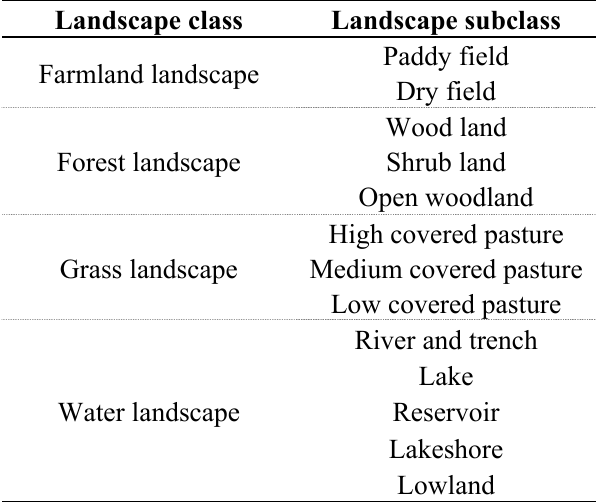
Table 1. Landscape classes of the study